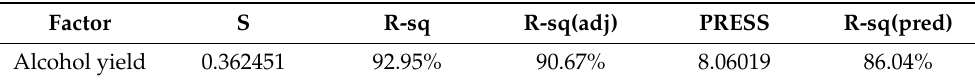
Table 4. Model summary from RSM analysis, displaying the R-squared and adjusted R-squared values.